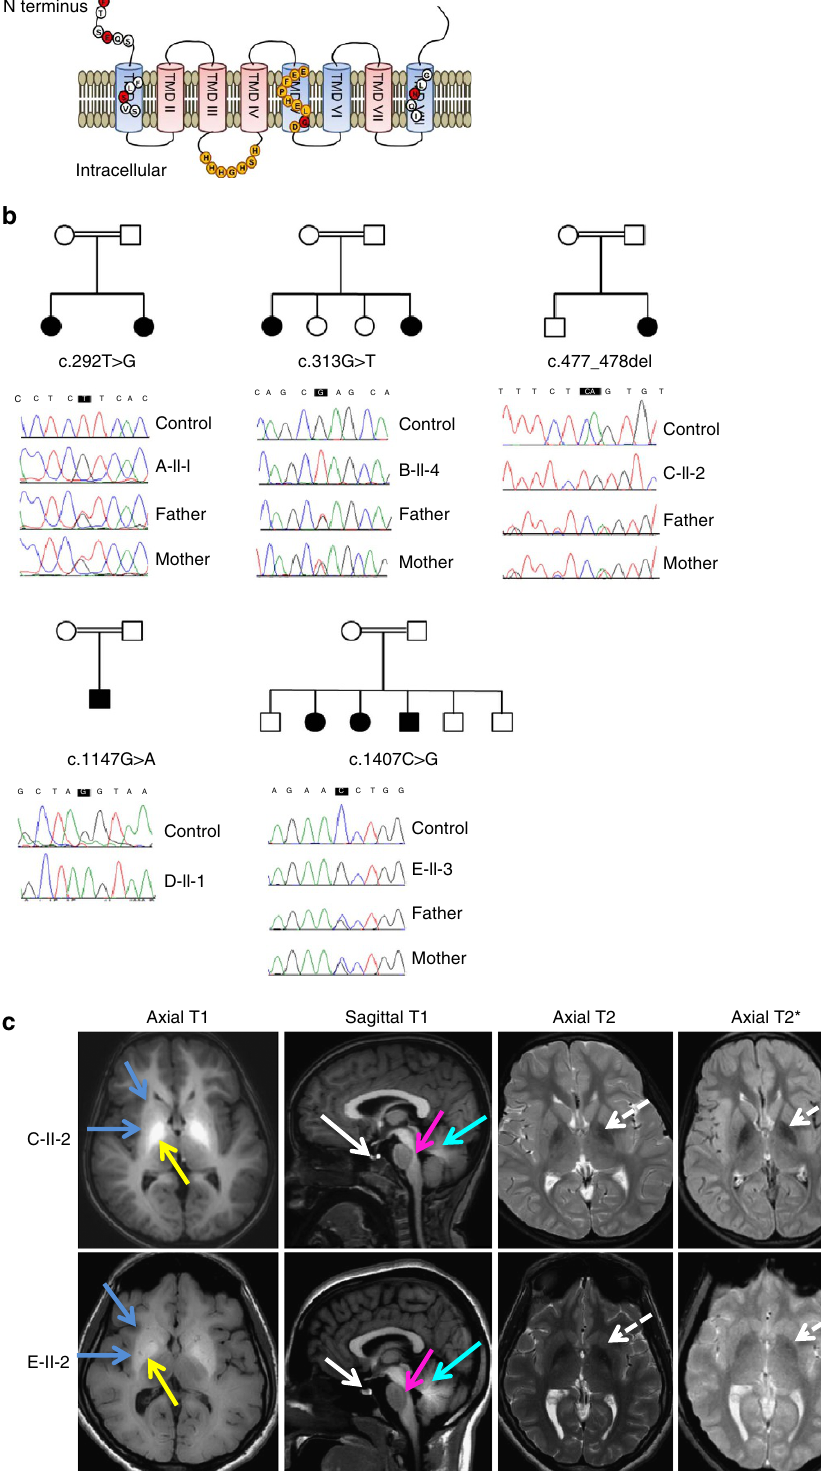
indicated extensive white matter involvement including the cerebellum, spinal cord and dorsal pons, with sparing of the ventral pons. Sagittal T1-weighted sequences demonstrated hyperintense signal of the anterior pituitary gland. Axial T2-weighted imaging (T2, T2* and FLAIR sequences) showed